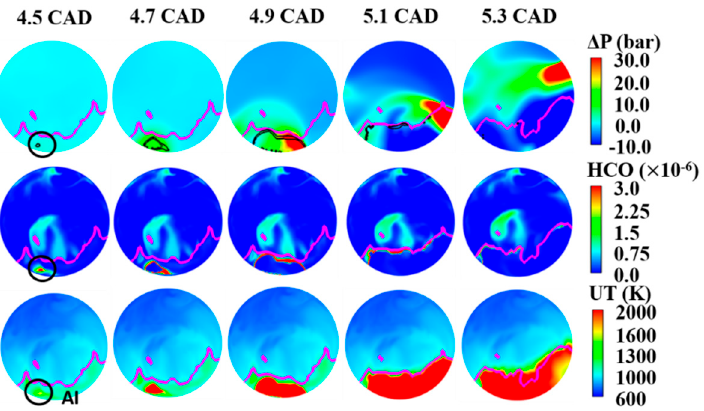
Figure 10. Evolution of ∆ P, mass fraction of HCO, and unburned temperature after the initial auto-ignition at ω = 0.5.